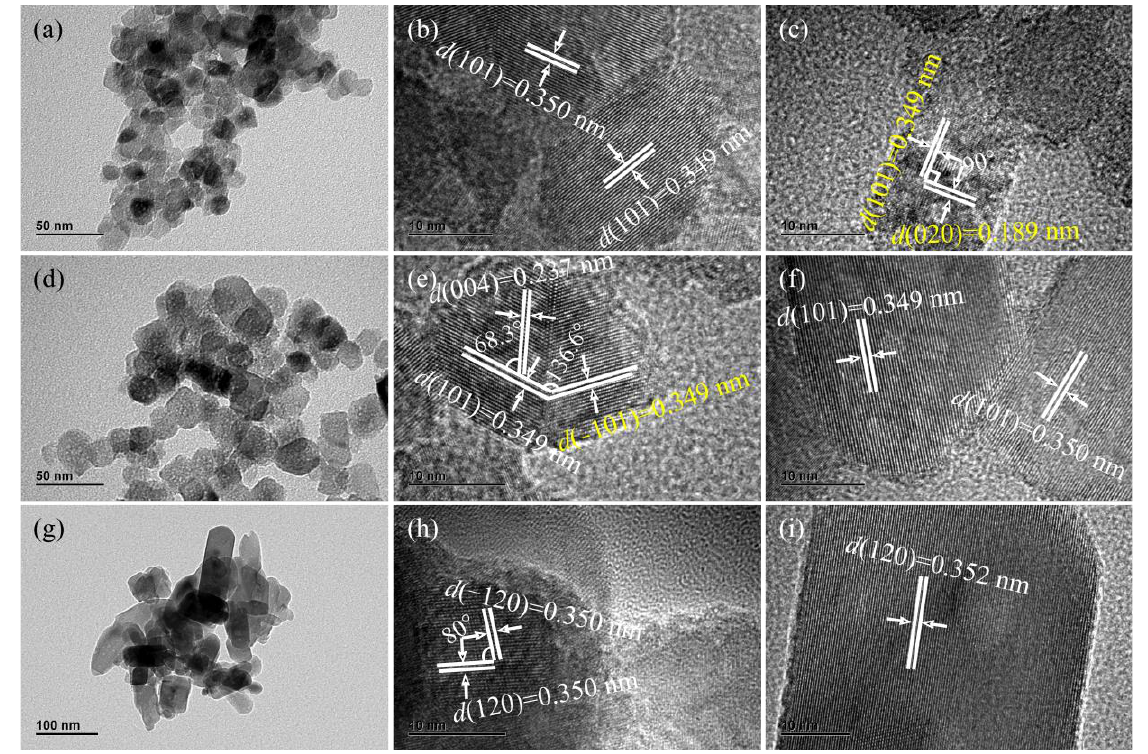
Figure 4. TEM and HRTEM images of the prepared ( a – c ) pH7.5 − T500 − TiO 2 , ( d – f ) pH9.5 − T500 − TiO 2 and ( g – i ) pH11.5 − T500 − TiO 2 samples under different pH value conditions.